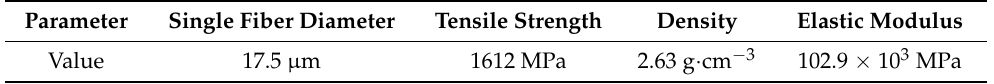
Table 1. Basic parameters of the CBF material.